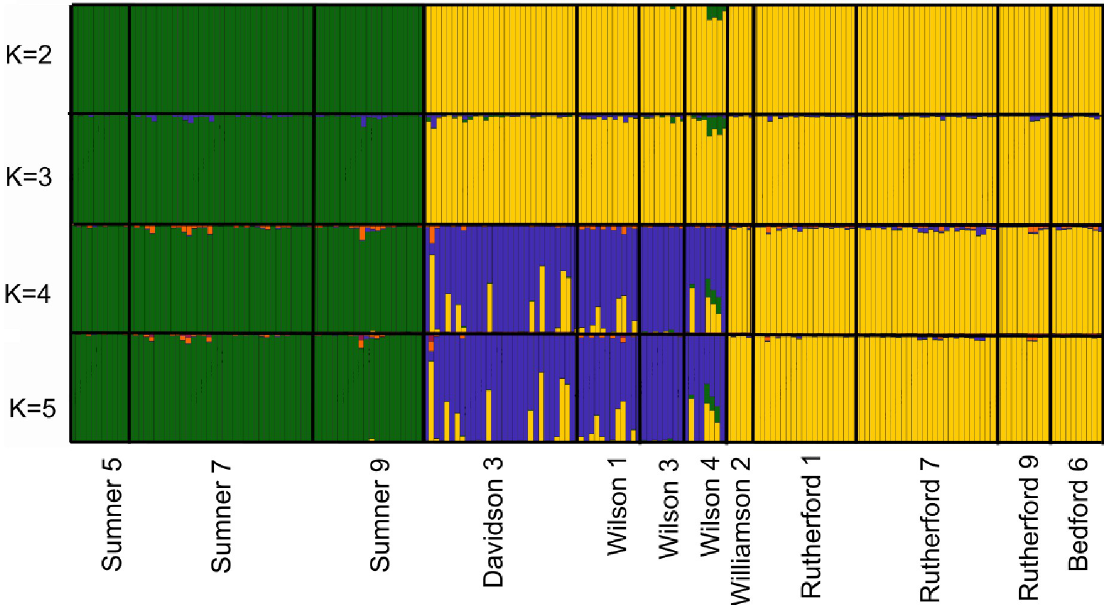
Fig 5. Bayesian assignment barplots. Results of Bayesian Assignment tests based on SNPs generated from GBS sequencing. Barplots indicate individual assignment probabilities for samples from 12 A . barbouri populations in Tennessee (K =